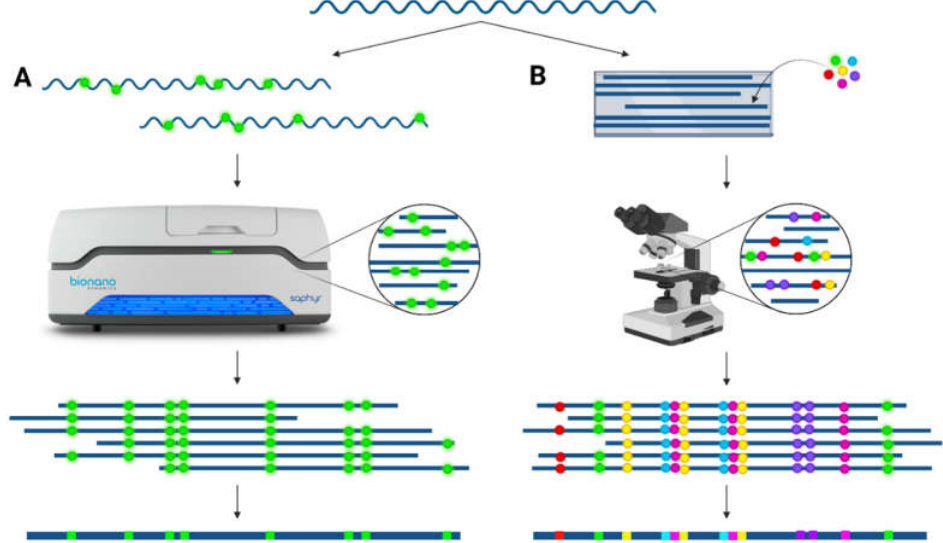
Figure 3. De novo assembly via optical mapping techniques. ( A ) Bionano optical mapping: ultralong (>100 kb) DNA fibers are fluorescently labeled on specific locations across the whole genome and subsequently linearized and scanned. These images are converted into molecules to visualize the labeling pattern across the DNA strand. By overlapping identical patterns, a consensus pattern can be created. ( B ) Fiber-FISH: ultralong (>300 kb) DNA fibers are stretched onto slides and hybridized with a combination of different fluorescently colored probes targeting the locus of interest. The slide is scanned using a microscope, allowing the detection of the different colors via scanning at different excitation levels. A consensus of the region of interest can be compiled based on overlapping colors and distances between the probes.